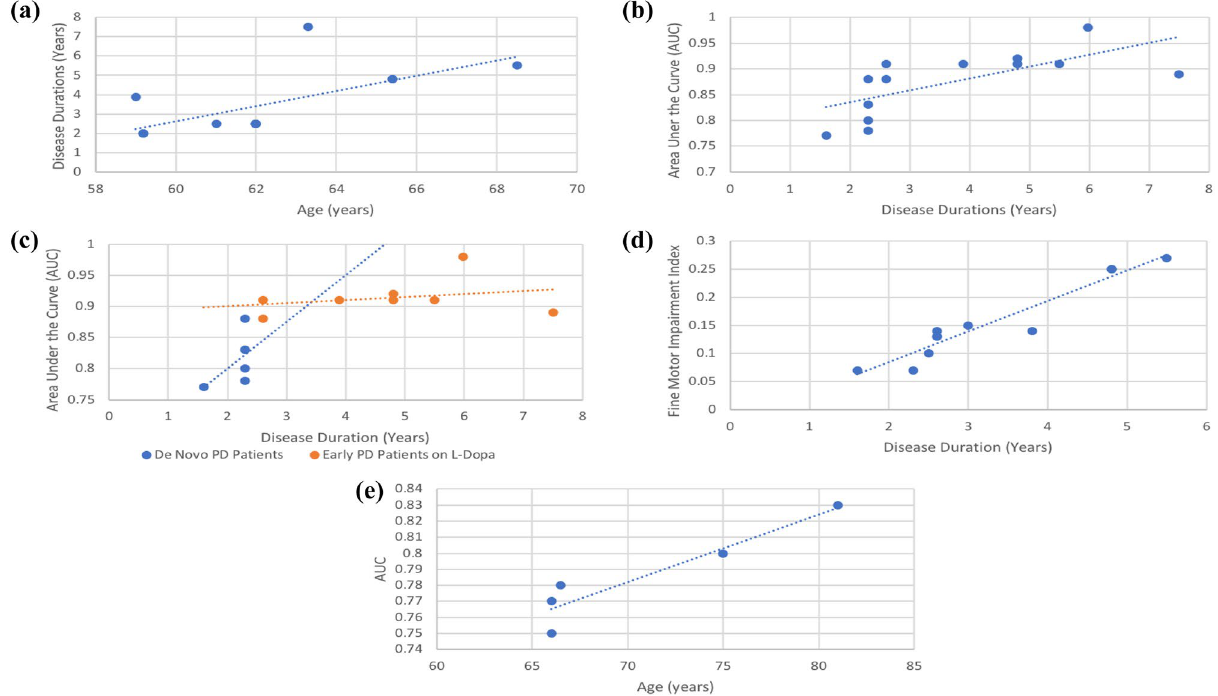
Figure 6. Evaluation of the impact of patients’ age and disease duration on the diagnostic performance of keystroke dynamics represented by the AUC. ( a ) Regression analysis results of PD patients age and years from diagnosis (disease duration). ( b ) Regression analysis results of PD studies reporting diagnostic AUC and disease duration reveals their significant association. ( c ) Pooled AUC of de novo PD patients (blue) and early PD patients on L-Dopa (orange) depicts the sharper increase in AUC with disease duration of de novo PD patients, compared to that of early, medicated PD patients. ( d ) Regression analysis results of Fine motor impairment index derived from the HT and the disease duration. ( e ) Regression analysis results of MCI patients age and diagnosis AUC.